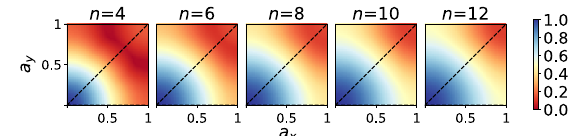
; a 0 . at a x y z ¼